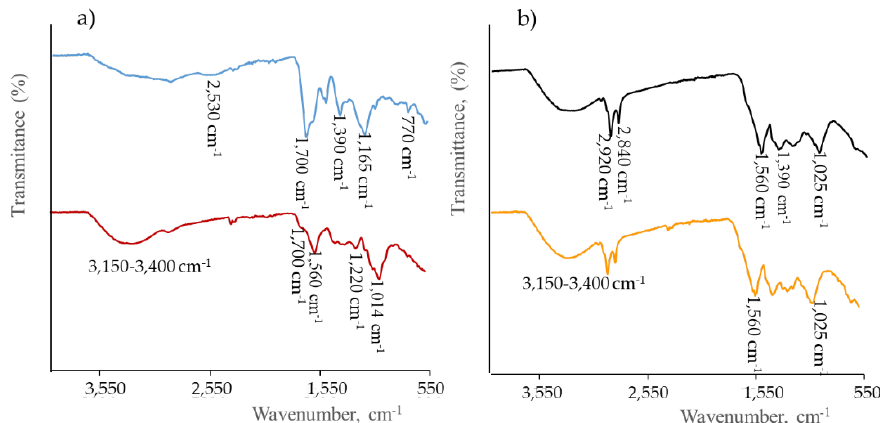
Figure 2. FTIR spectra comparison of: ( a ) GCDs ( — ) and TCDs ( — ); ( b ) P1CDs ( — ) and P2CDs ( — ).